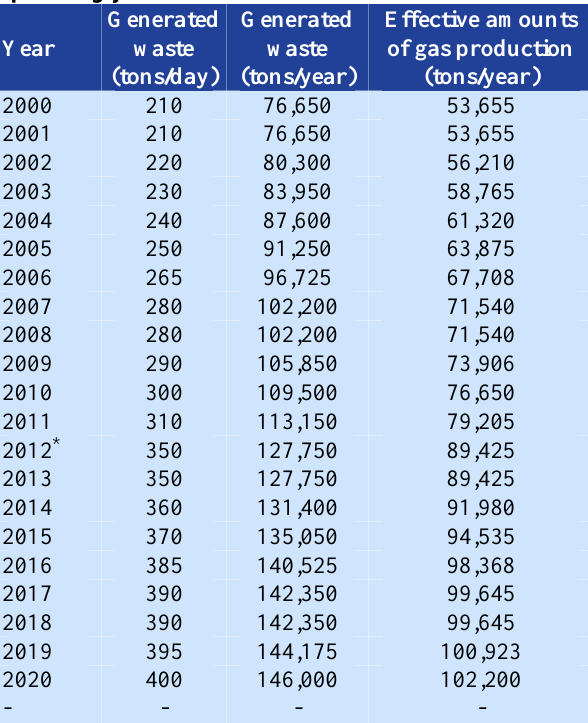
Table 4. The quantity of generated waste and their effective amounts of gas production in recent